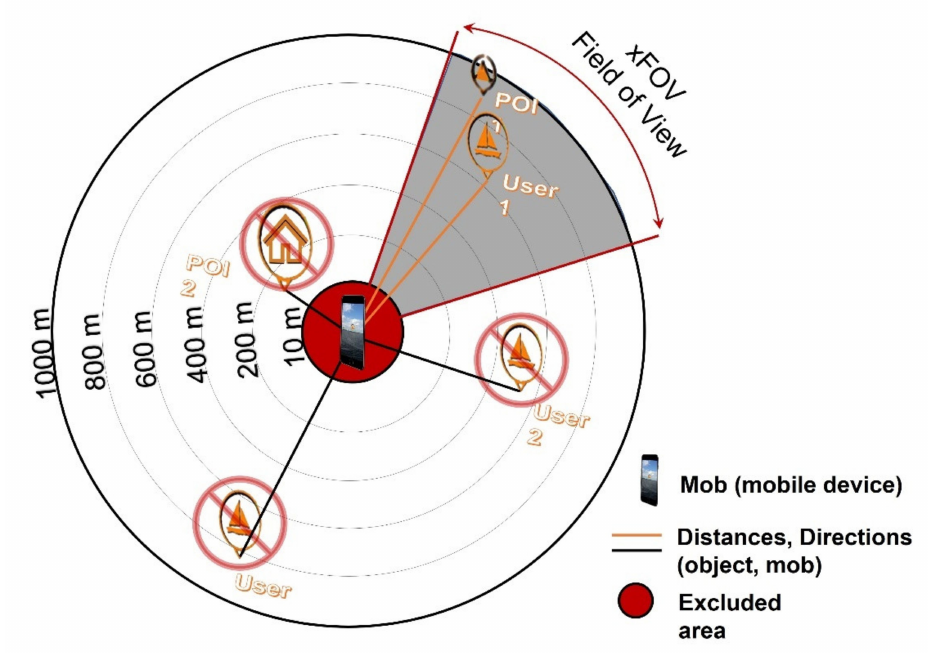
Figure 12. Concept of AR content matching in dynamic water conditions. Geographic objects are defined by distance criterion (5 distance thresholds), horizontal directions, and actual horizontal field of